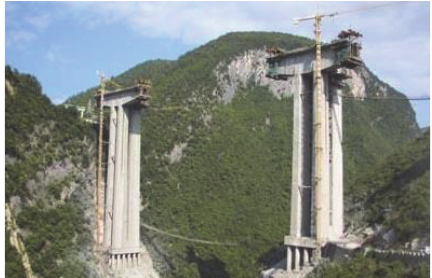
Figure 3: Cracks at the new poured box girder on 4# pier before blasting